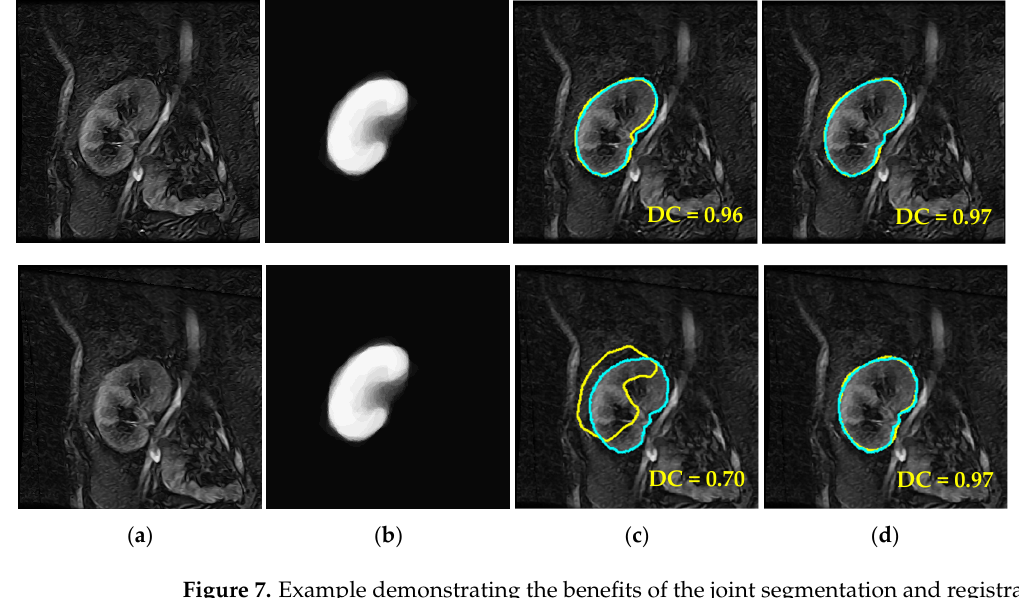
Figure 7. Example demonstrating the benefits of the joint segmentation and registration approach. ( a ) Two DCE-MRI input images, ( b ) constructed shape model, ( c ) segmented kidneys obtained by registration followed by segmentation, where the registration for the bottom image was not done accurately, and ( d ) segmented kidneys obtained by simultaneous segmentation and registration. The obtained kidney contours are marked in yellow, while the ground-truth segmentations are in cyan. The corresponding DC value is attached to each result.